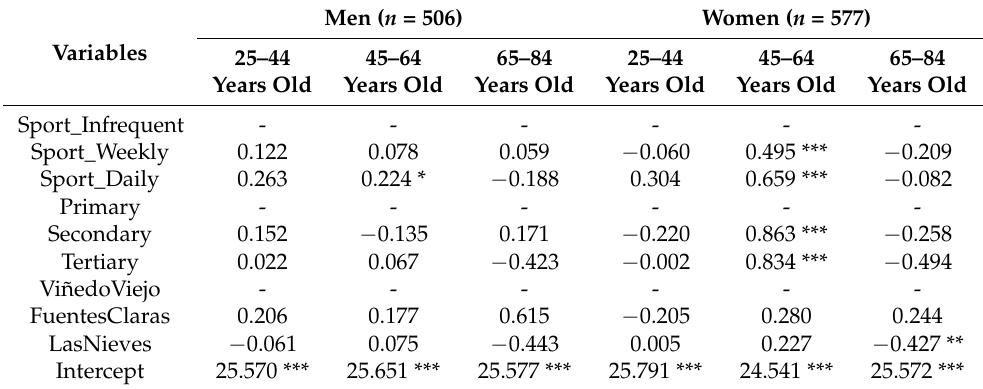
Table 4. Regression coefficients of health socio-economic determinants for men and women living in Casablanca (dependent variable: